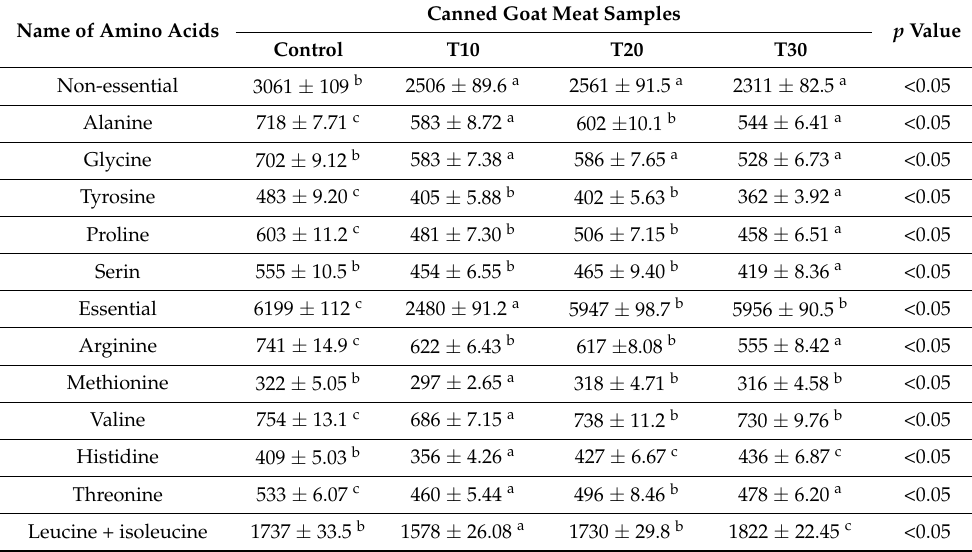
Table 3. Amino acid composition of canned goat meat, (mg/100